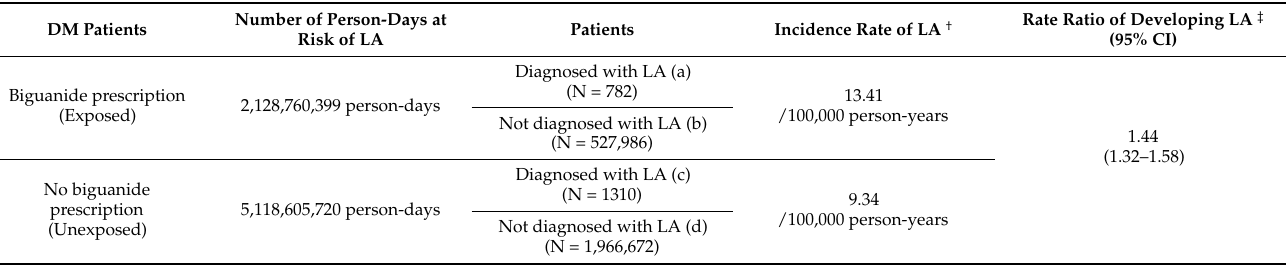
Table 2. Patient Group Classification, Incidence Rates, and Rate